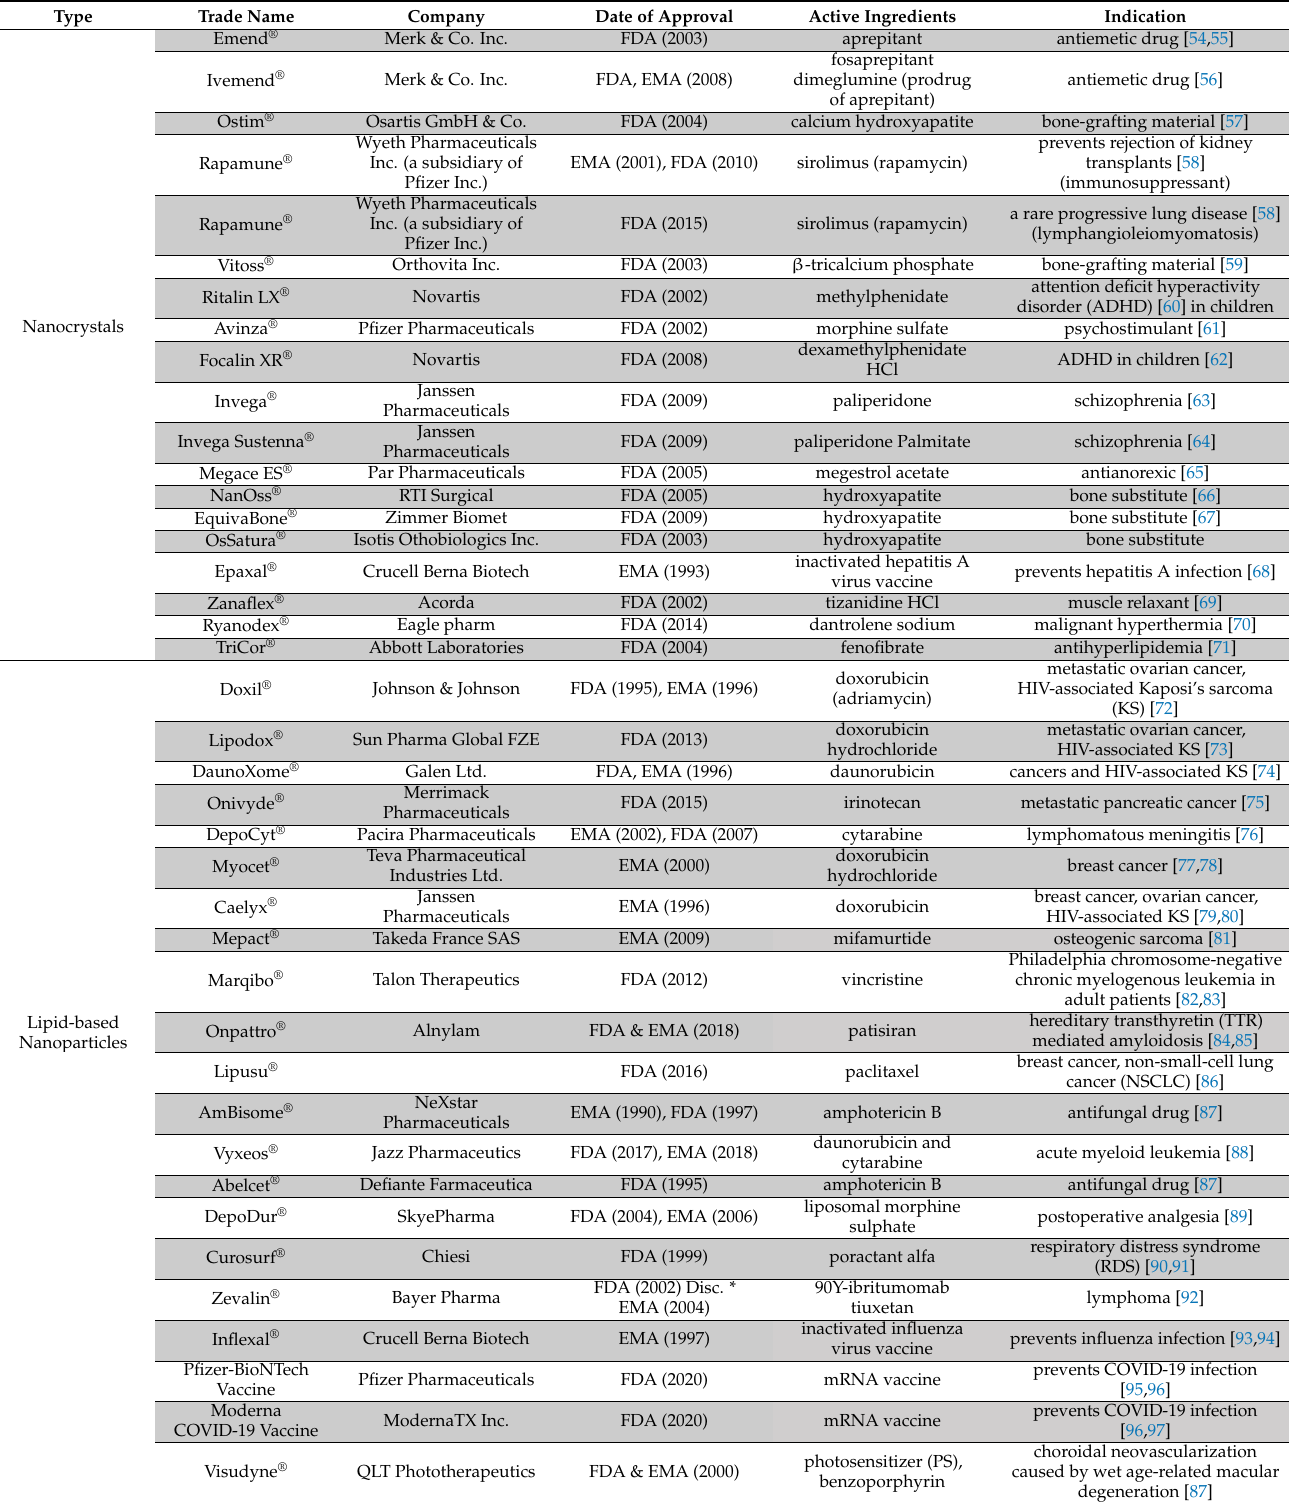
Table 1. List of globally marketed nanomedicines approved by the FDA and the EMA